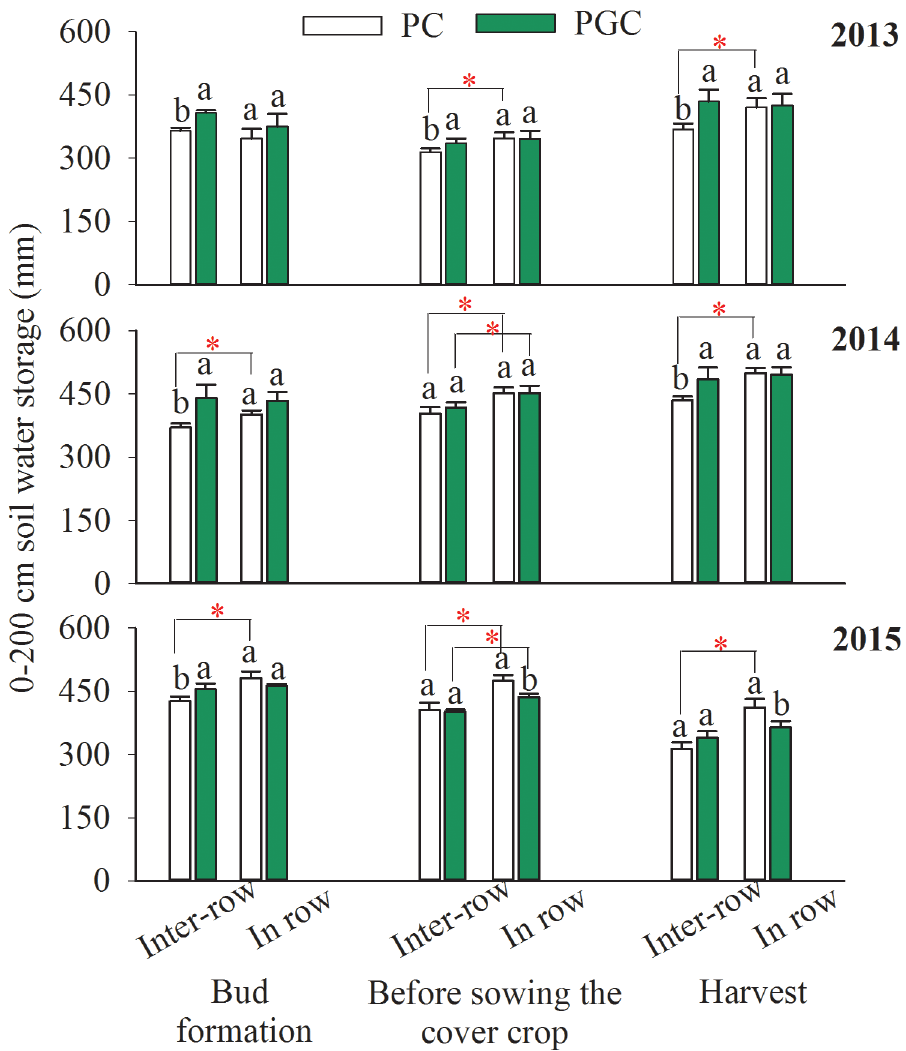
Fig 4. 0–200 cm soil water storage in each stage for 2013, 2014 and 2015. Lowercaseletters denote significantdifferences betweenPC and PGC for the inter-row or in-row (p (cid:20) 0.05). “ * ” indicates that the differences betweenthe inter-rowand in-row (connected by lines) of the PC or PGC treatment were significant (p (cid:20) 0.05). Bud formation means the bud formation stage of apple trees (in late March). Before sowingthe cover crop refers to the time before sowingthe rape (in mid-June). The apple harvest always occurs in early October in this region. Error bars were the